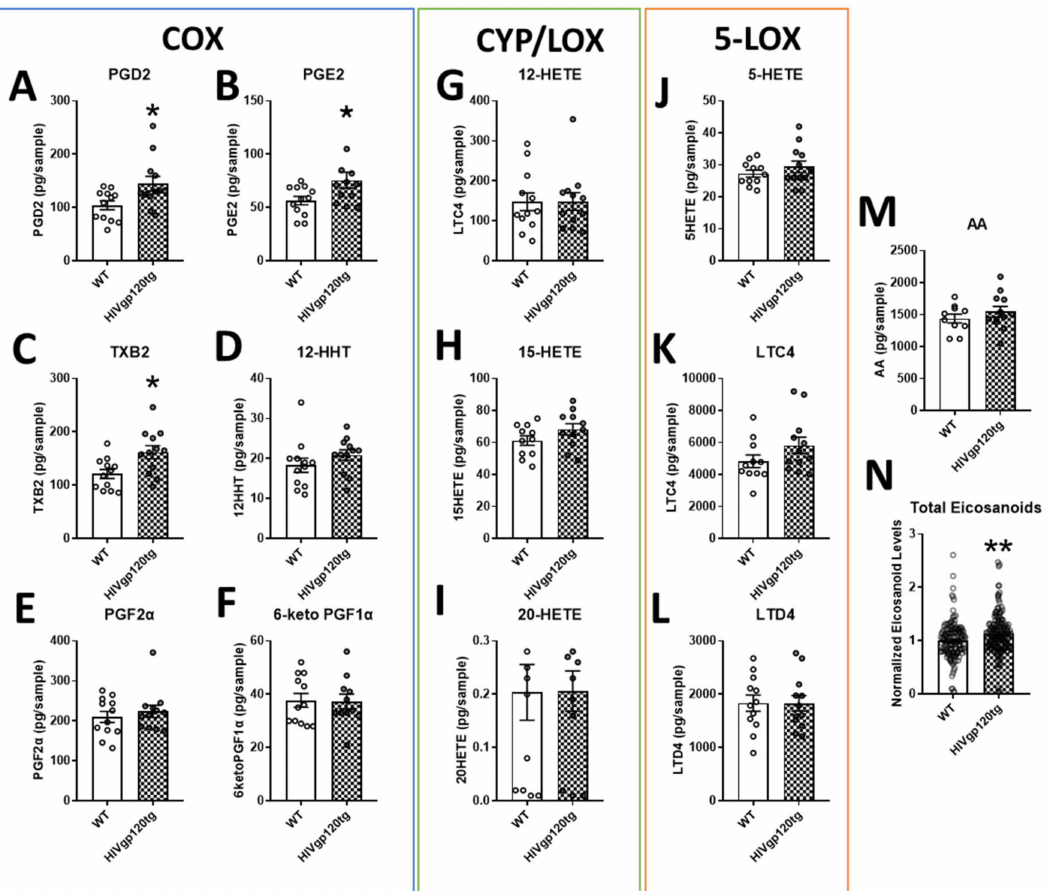
Figure 1. Quantification via LC-MS/MS of select eicosanoids in the brain extracts of wildtype (WT) and HIVgp120tg mice. COX pathway products outlined in blue ( A – F ), CYP/8-,12-,15-LOX products are outlined in green ( G – I ) and 5-LOX products are outlined in orange ( J – L ). The source material for the biosynthesis of eicosanoids, AA ( M ), and the total normalized values of all measured eicosanoid derivatives ( N ) are also shown. Values in graphs are mean ± s.e.m.; n = 12 (6 males and 6 females) per genotype; statistical analysis was performed using an unpaired t -test, * p ≤ 0.05, ** p ≤ 0.01 for difference to WT control. Individual data points are represented in the graphs by an